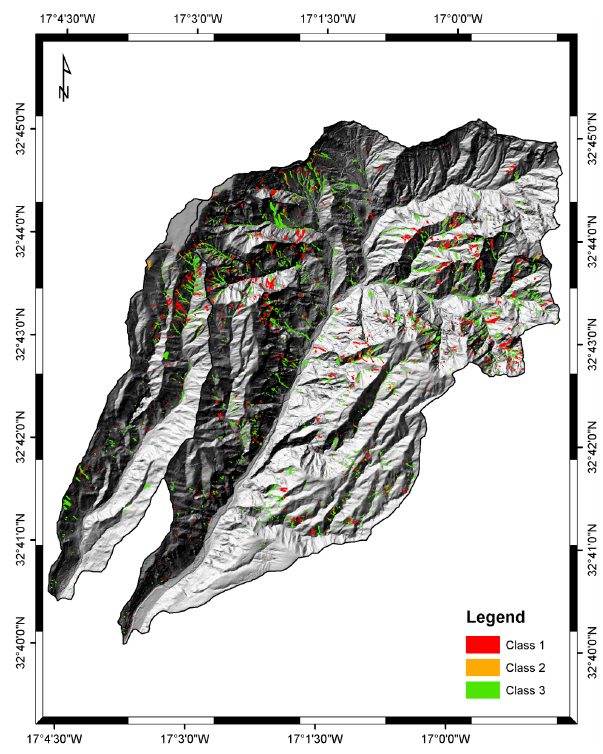
Fig. 7. Landslide inventory map for the Ribeira Brava